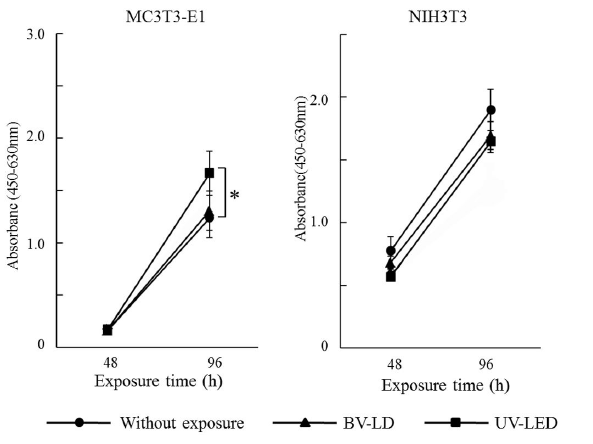
Figure 7. Chronological changes of cell proliferation in each specimen after titania treatment.